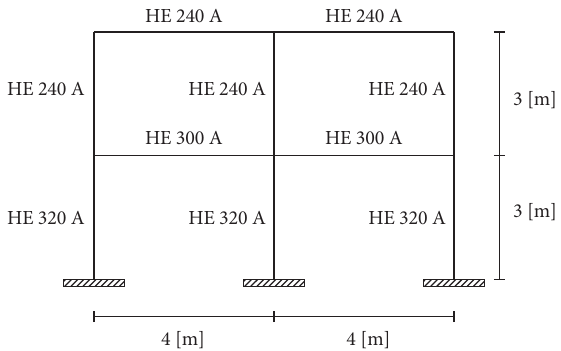
Figure 5: Frame with two floors and three columns. Table 4: Characteristics of the structural